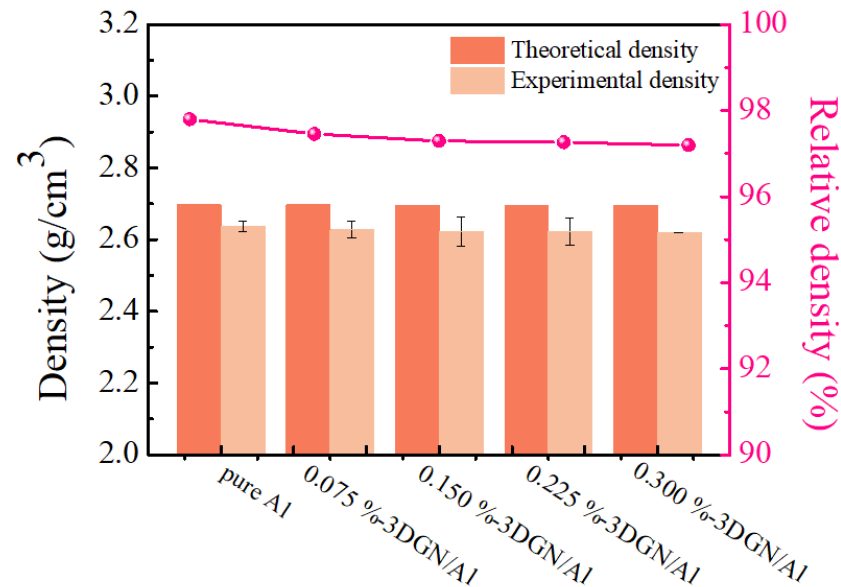
Figure 6. Theoretical density, experimental density, and relative density of pure Al and 3DGN/Al composites.